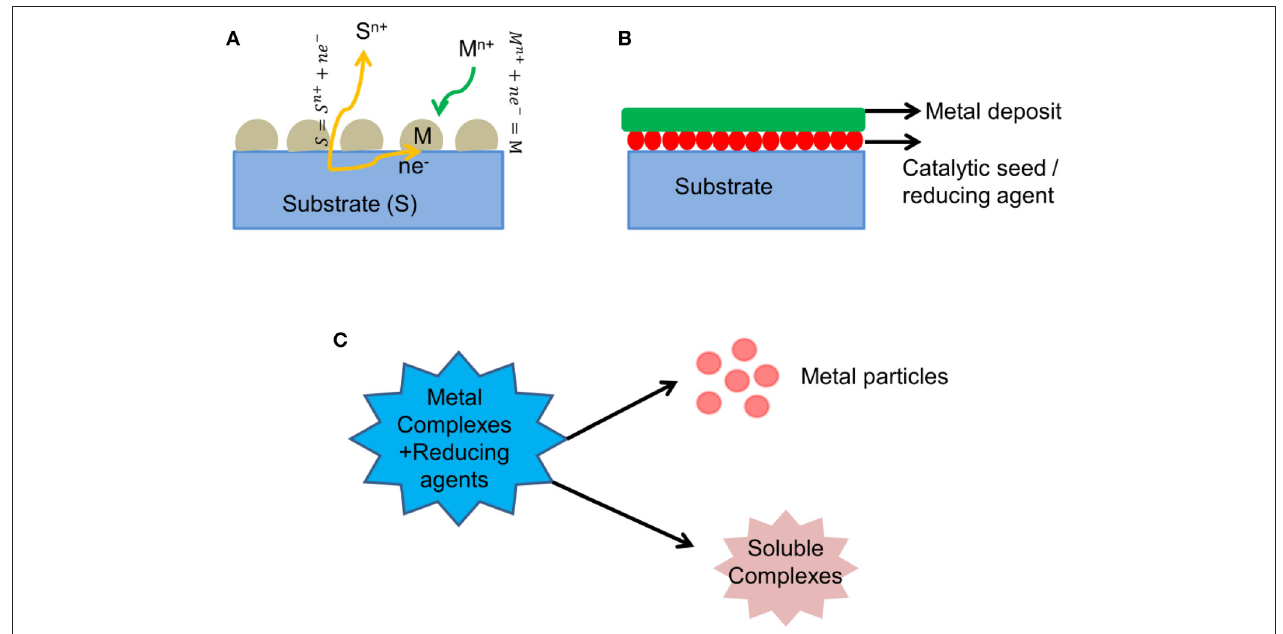
FIGURE 1 | Schematic diagram of various electroless deposition processes (A) Galvanic displacement reaction (B) Reduction using reducing agents (C) Disproportionation